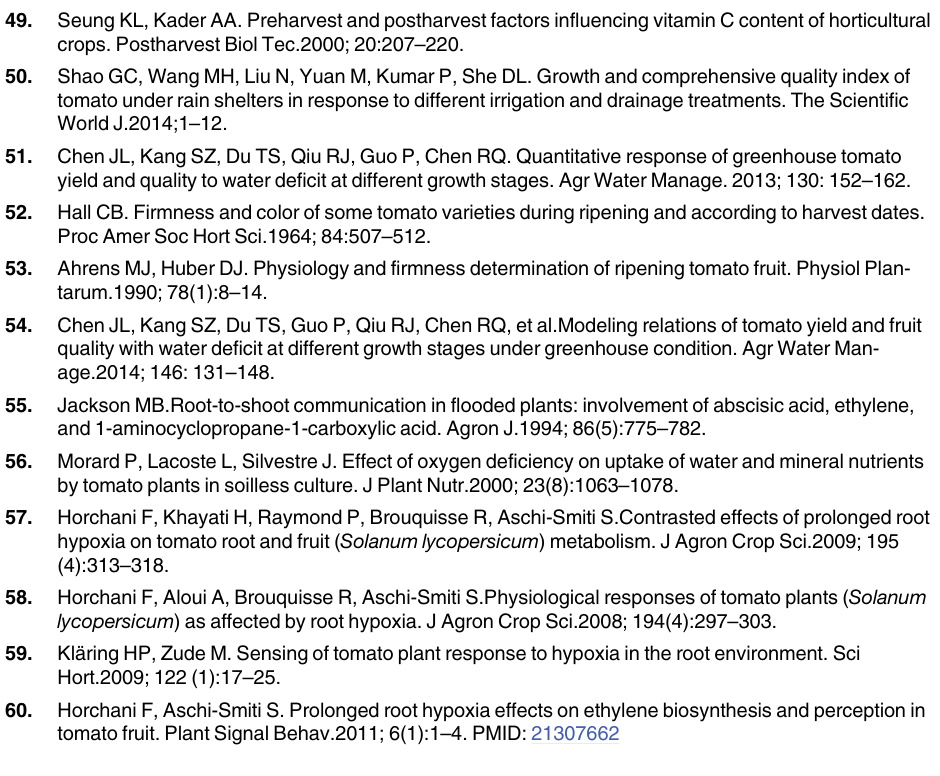
PLOS ONE | DOI:10.1371/journal.pone.0143322 December 2,